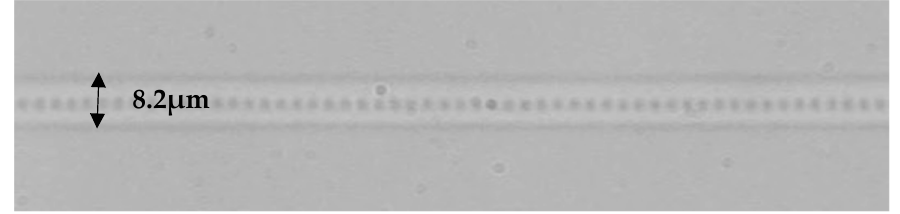
Figure 2. Microscope image of an FBG inscribed using the PbP femtosecond laser inscription method. The same inscription setup was used for the PlbPl inscription method, using a pulse